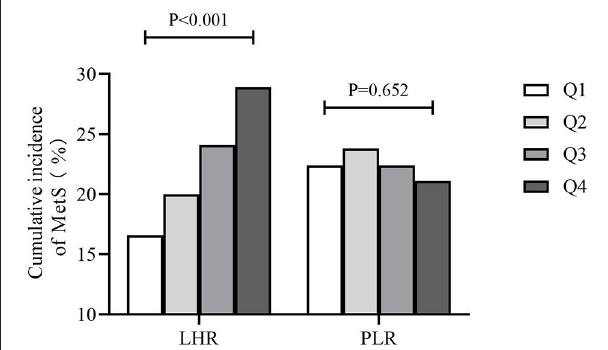
FIGURE 1 | Cumulative incidence of MetS during the 4.66-year follow-up. MetS, metabolic syndrome; PLR, platelet to lymphocyte ratio; LHR, lymphocyte to high density lipoprotein